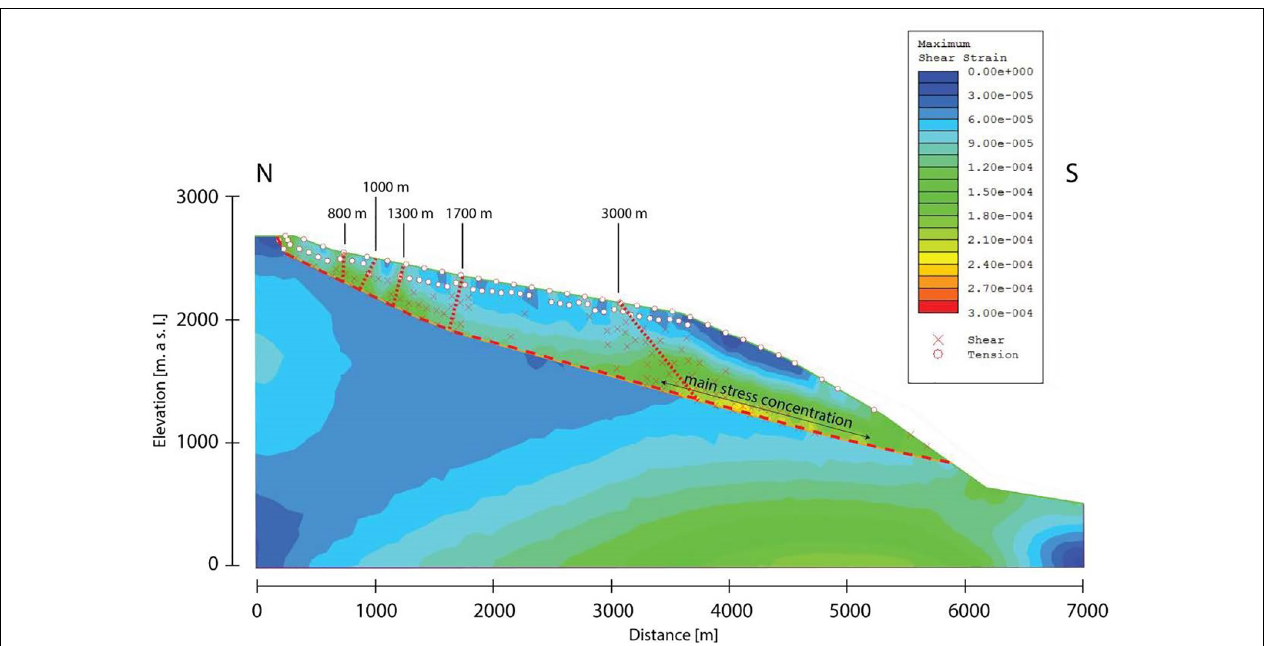
FIGURE 10 | Maximum shear strain plot in Phase2, indicating areas of high strain that could correspond to locations of secondary shear surfaces. These correlate well with field and remote sensing observations, as shown in Figures 3A , 9 .